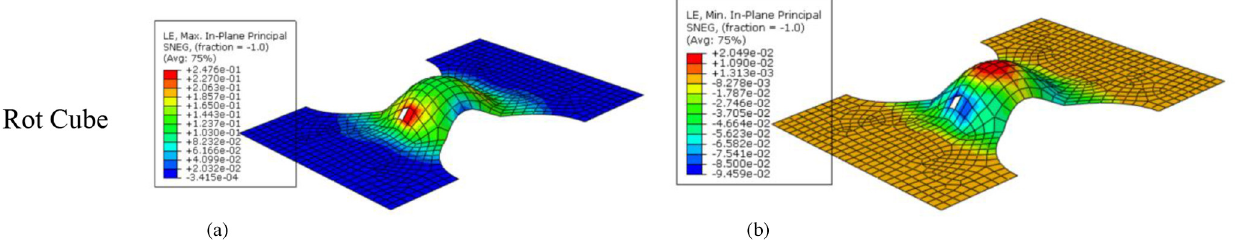
Fig. 11. (a) Maximum in-plane principle strain under plane stretching. (b) Minimum in-plane principle strain under plane